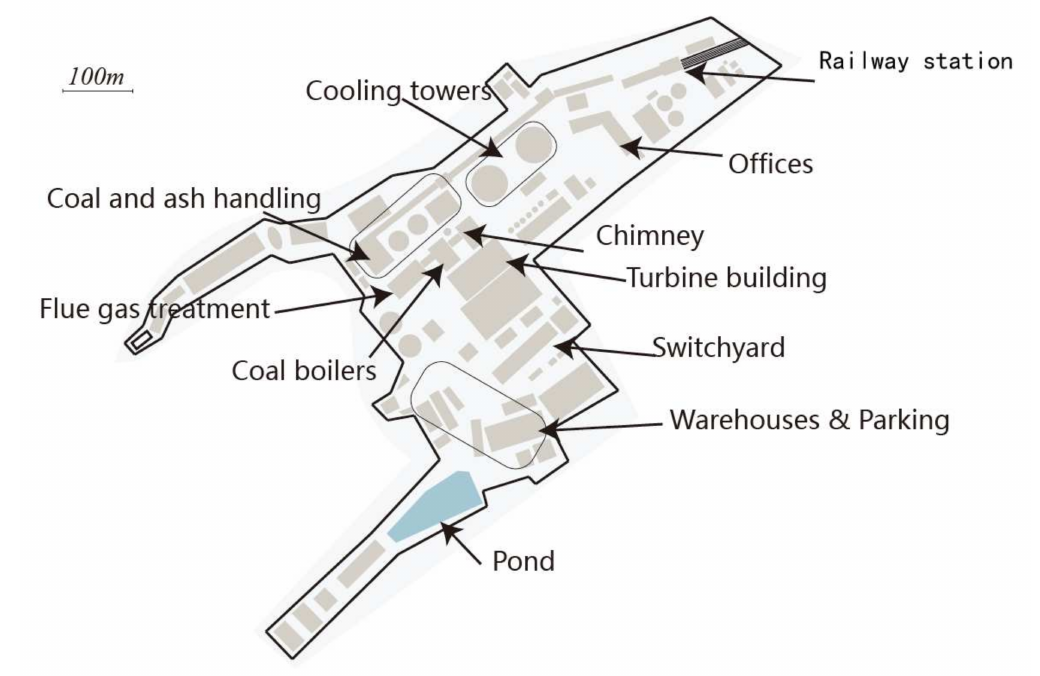
Figure 9. Dalian Taishan power station power plant site layout.